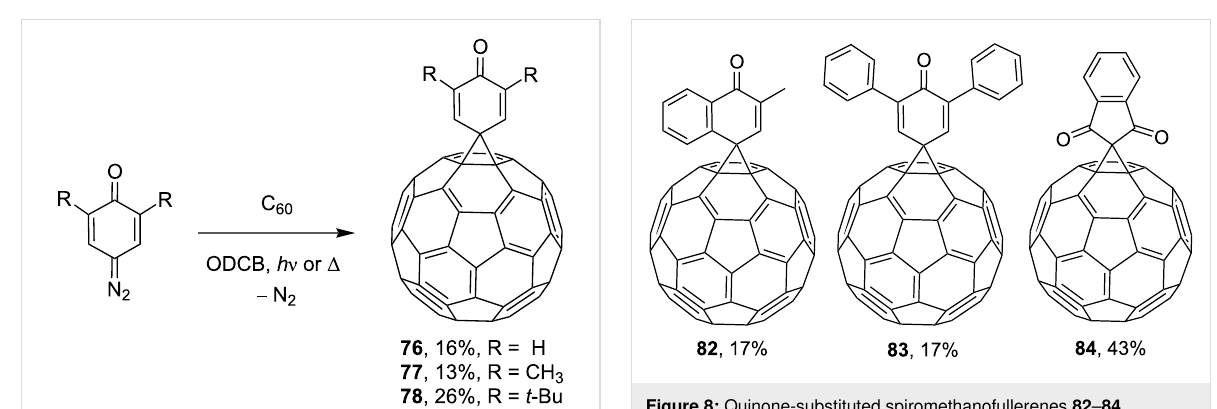
Figure 8: Quinone-substituted spiromethanofullerenes 82 – 84